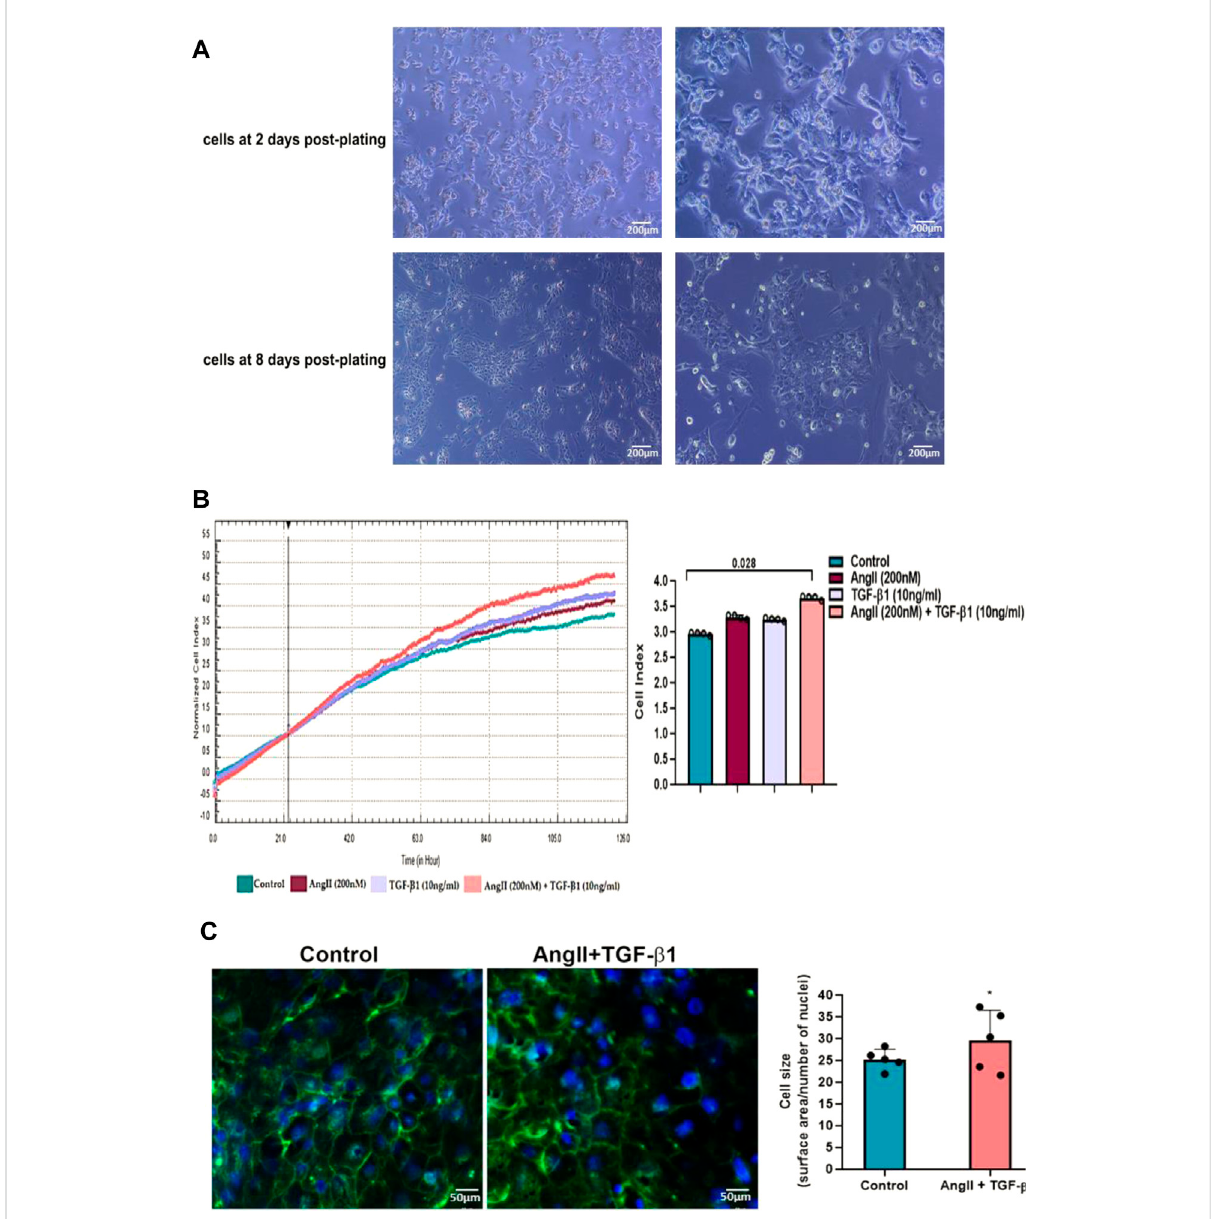
FIGURE 1 (A) .MorphologyofhiPSC-derivedcardiomyocytesproduced invitro ina2Dsystem.Representativephasecontrastimagesafter2and8 daysof culture of hiPSC-derived beating cardiomyocytes in monolayer in PC medium. The original magni fi cation was ×10, respectively ×20 (B) . Real-time proliferation assay of unstimulated hiPSC-CMs (control cells) and hiPSC-CMs stimulated with AngII or TGF- β 1 or with AngII + TGF- β 1 for 48 hours using the xCELLigence ® RTCA DP system. The impedance values were acquired automatically with the RTCA software and expressed as cell indexvalues.Dataaremeans±SDof4independentexperimentsinduplicateforeachexperimentalcondition.Thestatisticalsigni fi cance,noticeably different, was represented as *P < 0.05 value versus control cells. Two-way ANOVA test with Bonferroni post-test were applied (C) . Surface area quanti fi cation of unstimulated hiPSC-CMs (control cells) and stimulated hiPSC-CMs with AngII + TGF- β 1for 48 hours using FITC-conjugated wheat germ agglutinin (WGA) (green) to label cell membranes and DAPI (blue) to stain nuclei. The cell size was expressed as the ratio between the cell surface area and number of nuclei. Data are means ± SD of 5 independent experiments. Five different microscopic fi elds for each experimental condition were analysed. The statistical signi fi cance, noticeably different, was represented as * p < 0.05 value versus control cells. T-test was